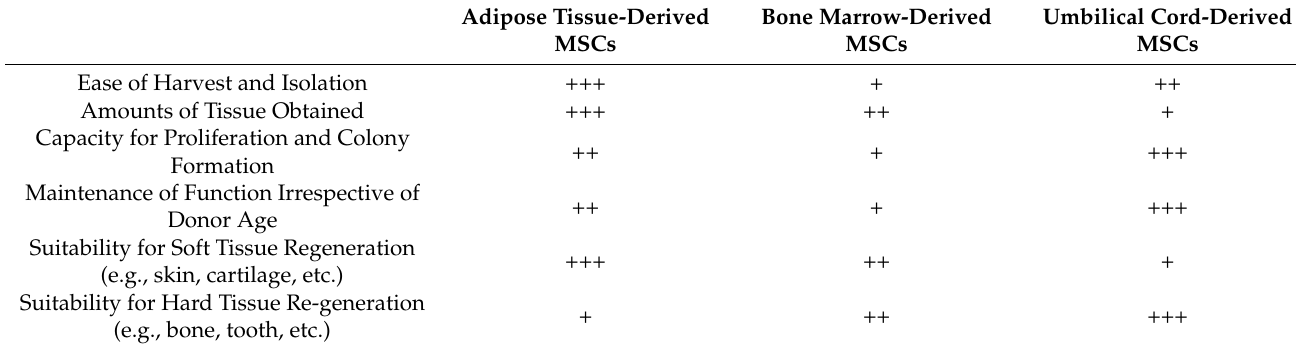
Table 2. A summary of MSC properties with respect to their isolation, proliferation, and differentiation [37,38].